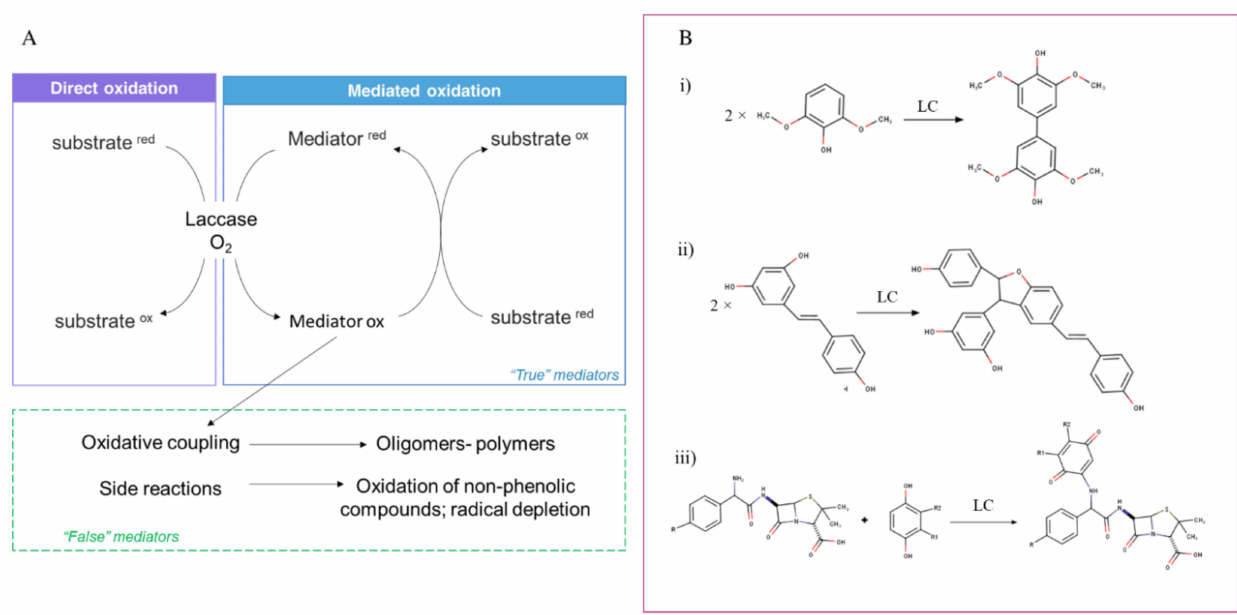
Figure 1. Oxidation of substrates by laccase. Panel ( A ) shows the direct and mediated oxidation mechanisms. The route of “false” mediators is also depicted. Panel ( B ) shows three examples of coupling reactions. In particular homomolec- ular coupling of 2,6-dimethoxyphenol (i) and resveratrol (ii), and the heteromolecular coupling of aminopenicillin and cathecol (iii).